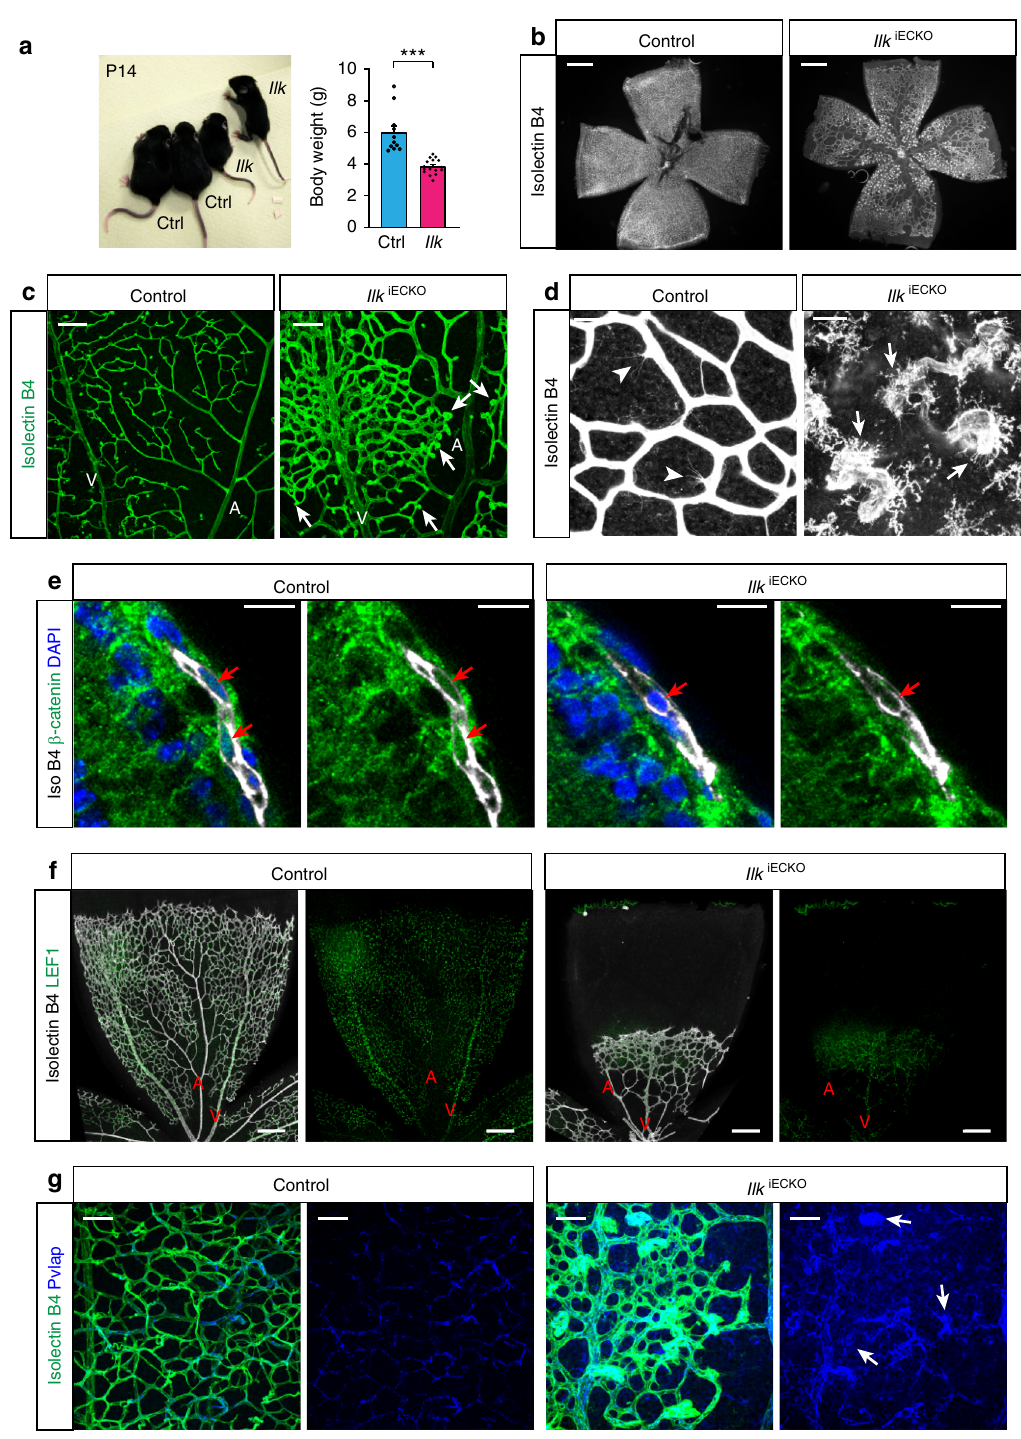
Fig. 3 Vascular abnormalities in Ilk mutants phenocopy aspects of FEVR. a Picture and body weight analysis of P14 Ilk iECKO mutants and littermate controls. Error bars, s.e.m. p values (*** p < 0.001), Student ’ s t test ( n = 6 animals/group). b Overview images of the isolectin B4-stained P14 control and Ilk iECKO retinal vasculature. Scale bar, 500 μ m. c Confocal images of the isolectin B4-stained vasculature in the control and Ilk iECKO nerve fi ber layer. Arteries (A), veins (V), and bulging EC clusters emerging from mutant capillaries (arrows) are indicated. Scale bar, 100 μ m. d High contrast images of isolectin B4- stained vessels in the P14 nerve fi ber layer. Filopodia-extending sprouts (arrowheads) can be seen on control capillaries, whereas blunt ends of Ilk iECKO vessels are associated with isolectin B4 + macrophages (arrows). Scale bar, 25 μ m. e Confocal images of β -catenin (green) and isolectin B4 (white) stained control and Ilk iECKO P6 retina sections. Presence (control) or absence ( Ilk iECKO ) of β -catenin in endothelial nuclei (red arrows) in images with or without DAPI signal. Scale bar, 20 μ m. f Overview images of LEF1 and isolectin B4 stained retina of control and Ilk iECKO . Arteries (A) and veins (V) are indicated. Scale bar, 200 μ m. g Confocal high magni fi cation images of Pvlap (blue) and isolectin B4 (green) stained control and Ilk iECKO retinas. Note enhanced Pvlap staining of Ilk iECKO vessels and strong signal in distal EC clusters (arrows). Scale bar, 50 μ m. Source data are provided as a Source Data fi le